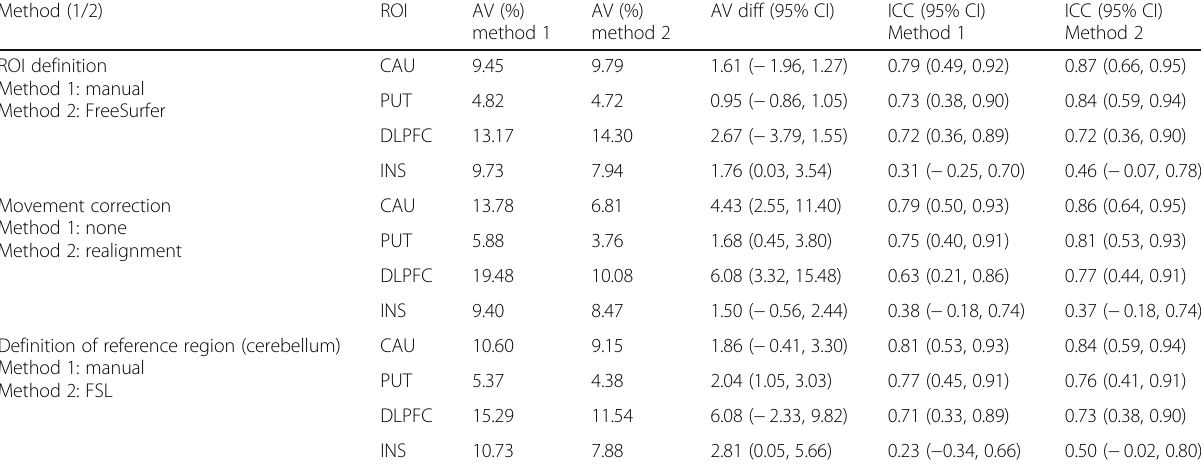
Table 3 Two sets of mean absolute variability (AV) values and intraclass correlation coefficients (ICC) of the binding potential (BP ND ) of [ 11 C]SCH23390 in four brain regions derived from two different methods (each defined in the leftmost column) in each of three parts of the image analysis process: (1) manual/FreeSurfer ROIs, (2) no realignment/realignment, and (3) manual cerebellum